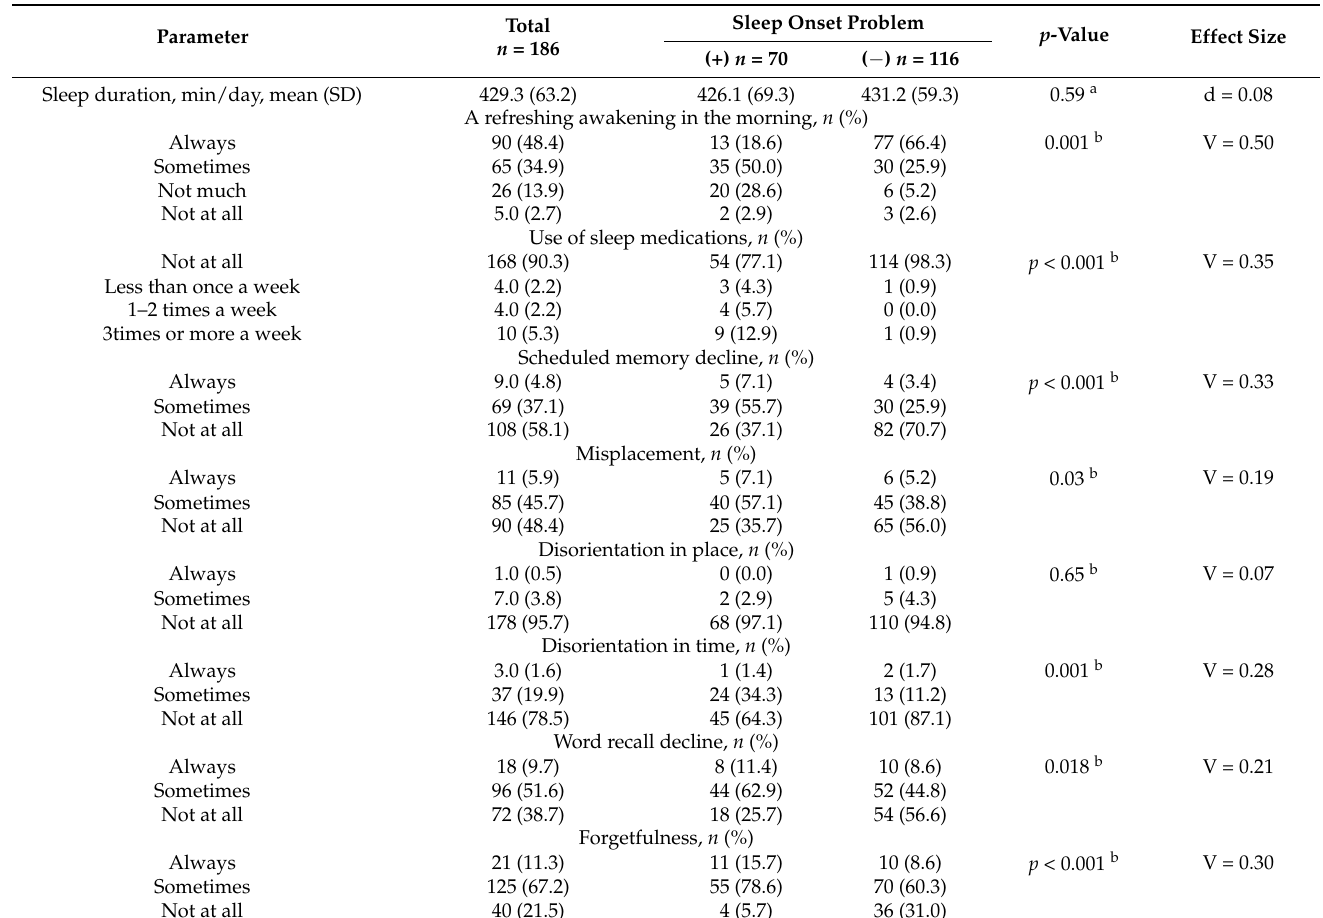
Table 2. Comparison of sleep duration and quality, and SCC between the participant with and without sleep onset problem.